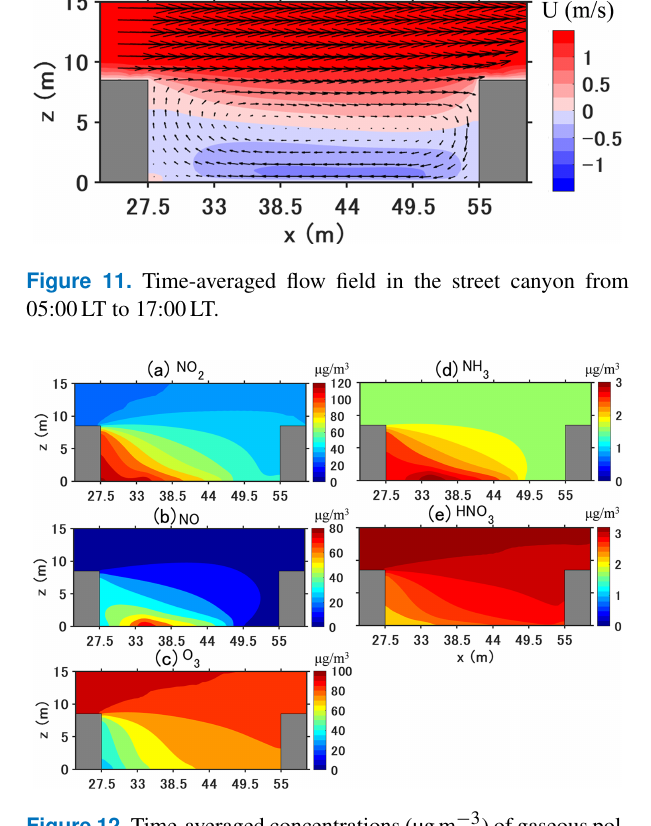
Figure 12. Time-averaged concentrations (µgm − 3 ) of gaseous pol- lutants in the street canyon from 05:00LT to 17:00LT.